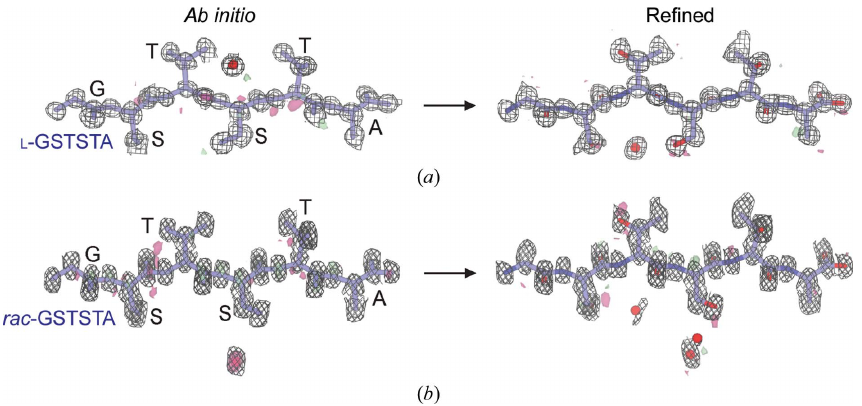
Figure 2 Ab initio structures and electrostatic potential maps of l -GSTSTA ( a ) and racemic GSTSTA ( b ). Each map in ( a ) is overlaid onto the initial atomic coordinates calculated by SHELXD from MicroED data. Each map in ( b ) is overlaid onto its corresponding refined model. The 2 F o (cid:2) F c map represented by the black mesh is contoured at 1.2 (cid:6) . Green and red surfaces represent F o (cid:2) F c maps contoured at 3.0 (cid:6) and (cid:2) 3.0, respectively. Modeled waters are present as red spheres. The waters modeled in the ab initio solution in ( a ) and the refined structure in ( b ) are related by